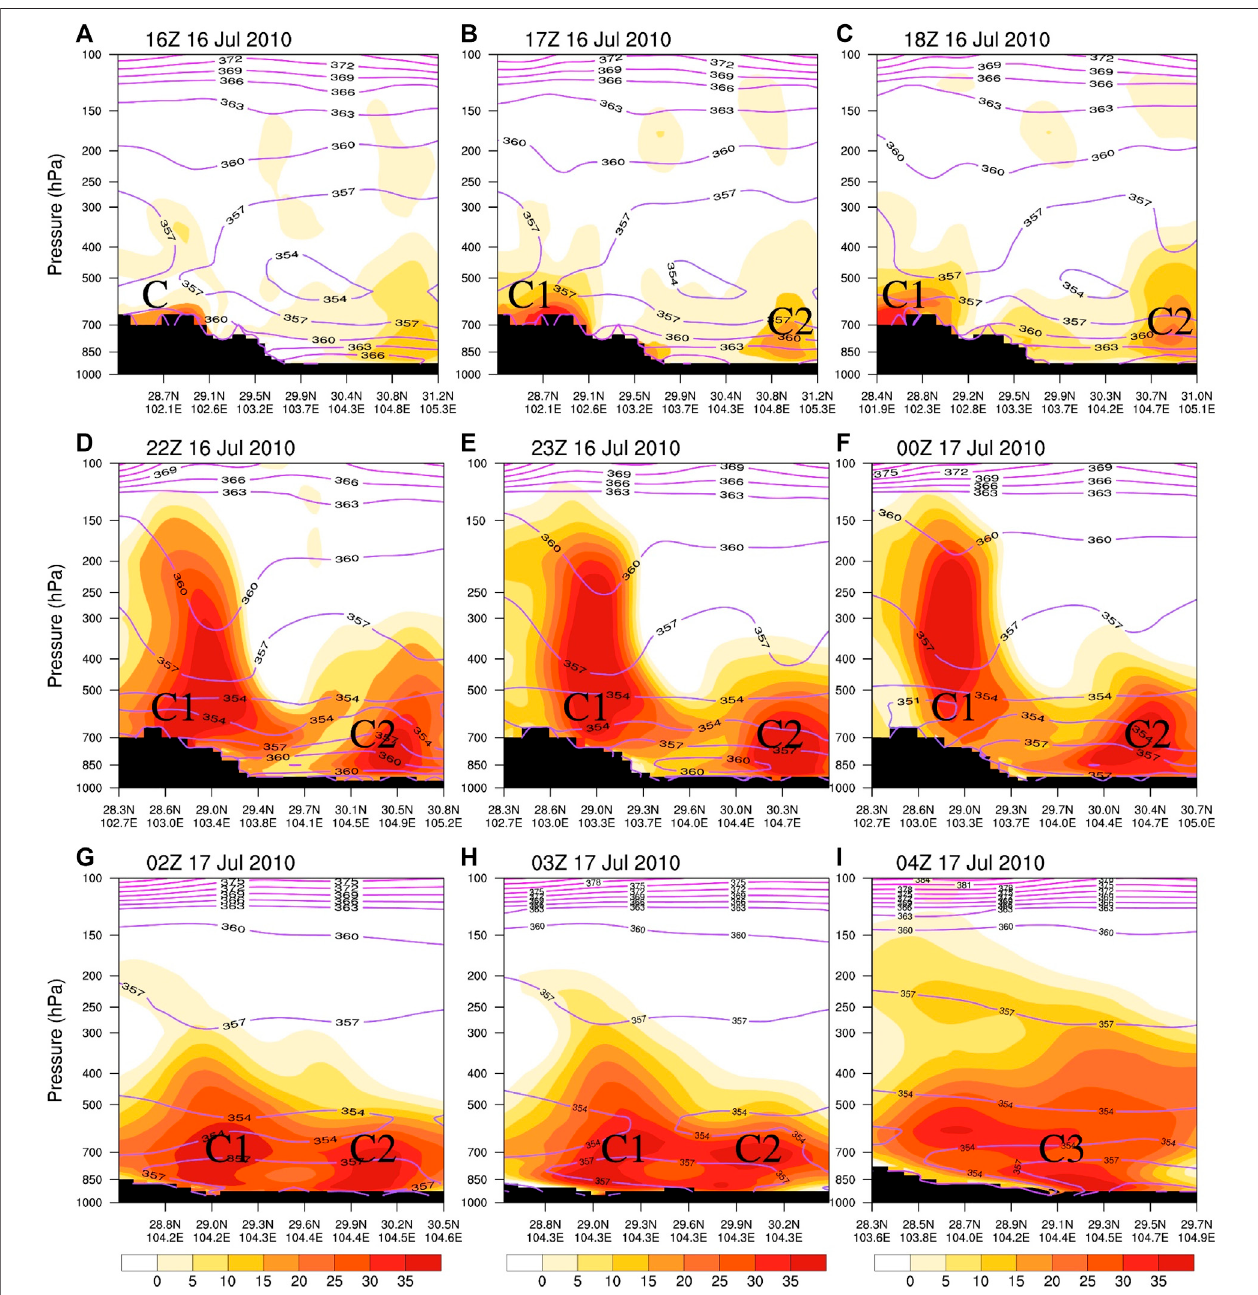
FIGURE8| Verticalcrosssections ofthepseudoequivalent potential temperature (K,contours)andrelativevorticity(10 − 5 s − 1 ,shaded)fromtheCTLexperimentat (A) 16:00 UTC July16, (B) 17:00 UTC July 16, (C) 18:00 UTC July 16, (D) 22:00 UTC July 16 (E) 23:00 UTC July 16, (F) 00:00 UTC July 17, (G) 02:00 UTC July 17, (H) 03:00 UTC July 17, and (i) 04:00 UTC July